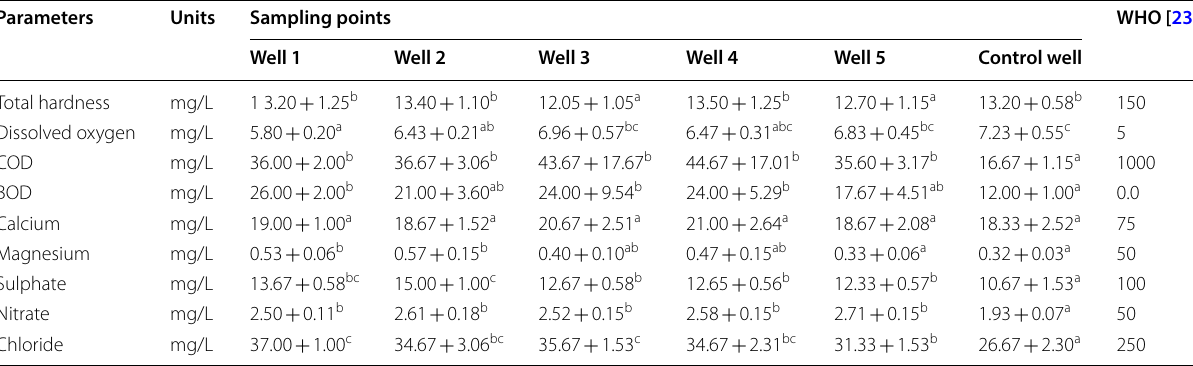
For each parameter, means with the different letters (superscripts) are significantly different ( p < 0.05), using Duncan’s multiple range test